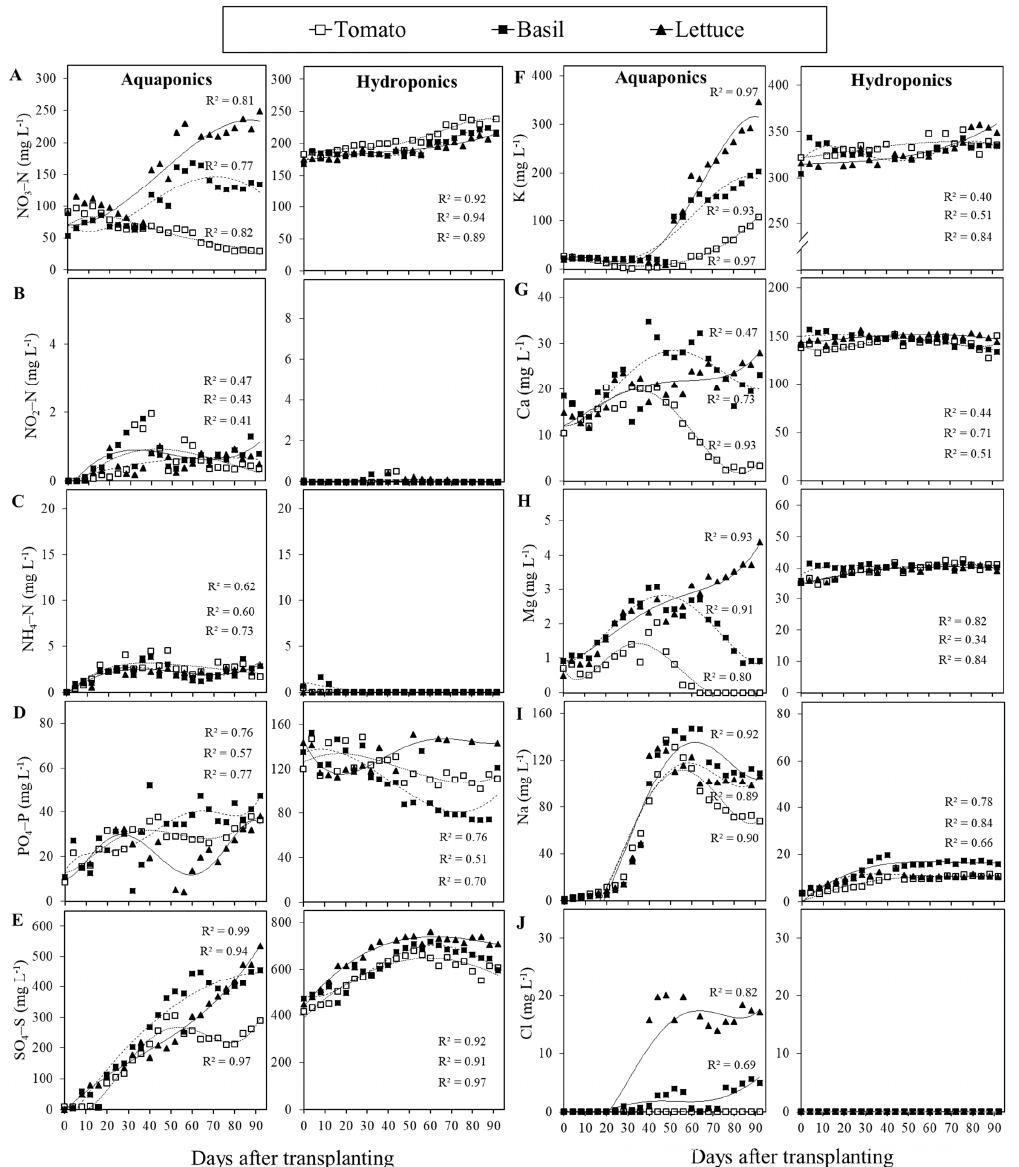
Figure 4. Changes in macronutrient ( A – J ) levels in the aquatic phase of tomato-, basil-, and lettuce-based aquaponics and hydroponics systems during a 3-month production period. Water samples were collected once every two days at two di ff erent locations in the system (fish tank or nutrient reservoir and hydroponic culture unit) and analyzed using ion chromatography (or HACH reaction kits for NO 2 –N and NH 4 –N). Each data point is the mean of 3